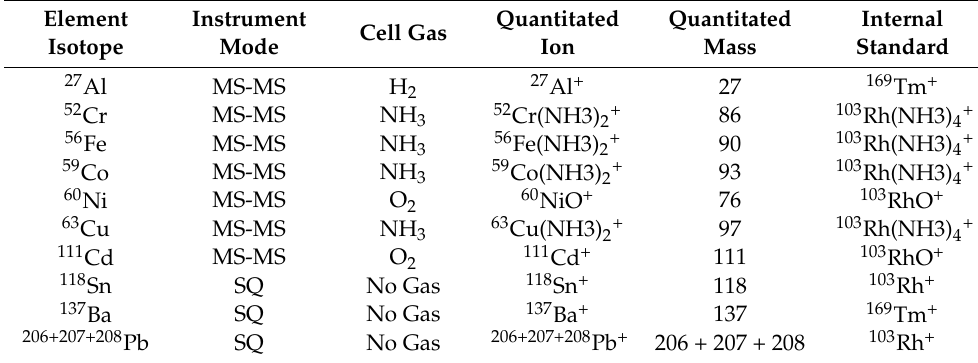
Table 1. Instrument Modes and Internal Standard Assignments. Quantitated Quantitated Internal Element Instrument Cell Gas Ion Mass Standard Isotope Mode 27 Al MS-MS H 27 Al + 27 169 Tm + 2 52 Cr MS-MS NH 52 Cr(NH3) 2+ 3 Fe MS-MS NH 3 MS-MS MS-MS MS-MS NH 3